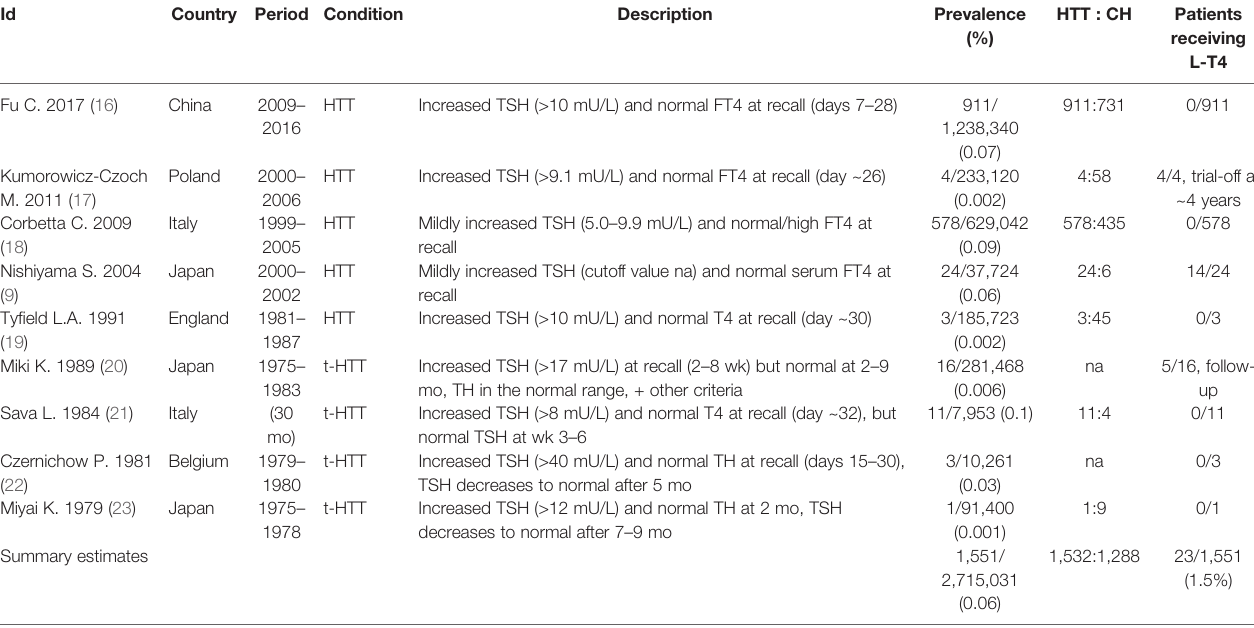
TABLE 1 | Prevalence of neonatal